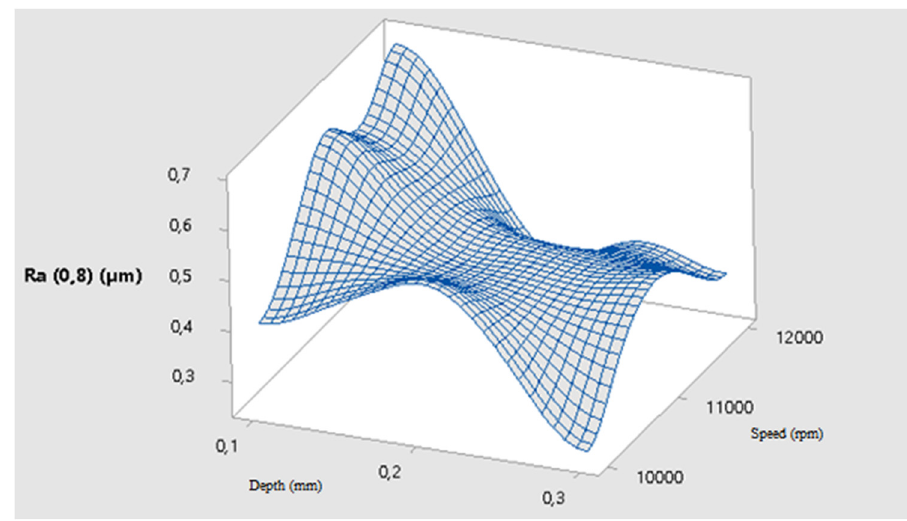
Figure 11: E ff ects of depth of cut and rev on surface roughness.